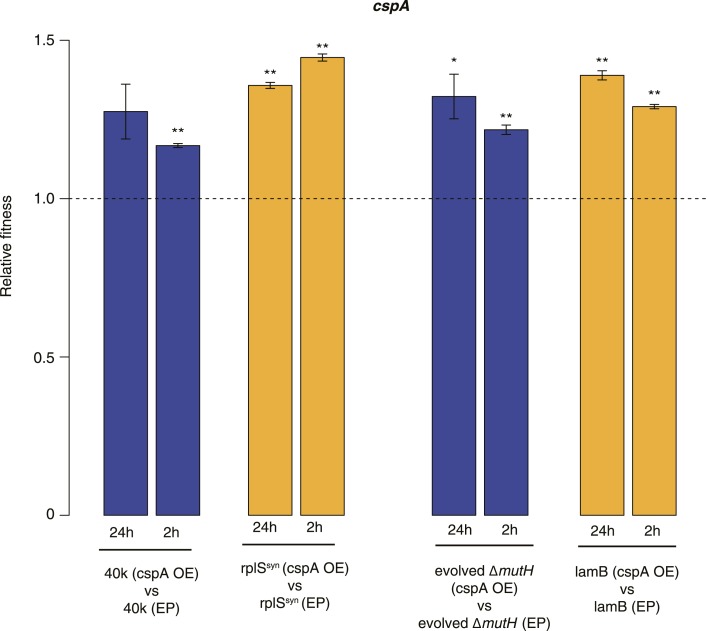
Relative fitness in competition experiments terminated in mid-exponential phase (cspA).OE: overexpression; EP: empty plasmid.